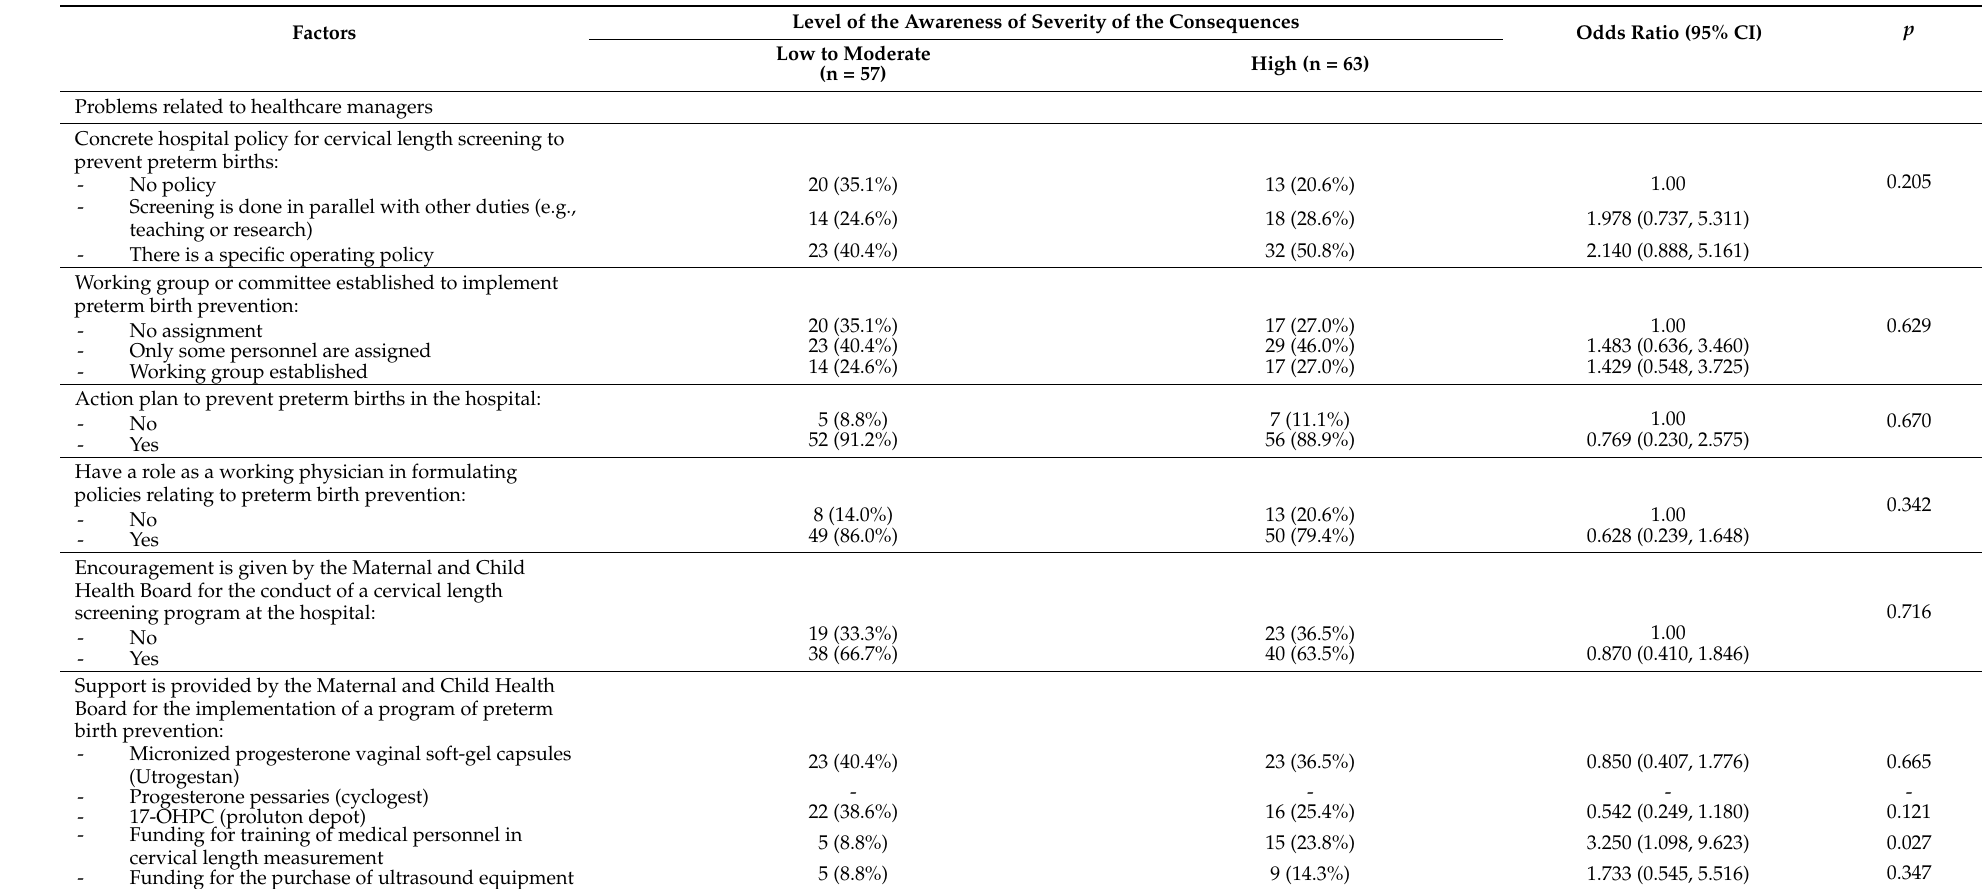
Table 3. Factors associated with awareness of the severity of the consequences of preterm